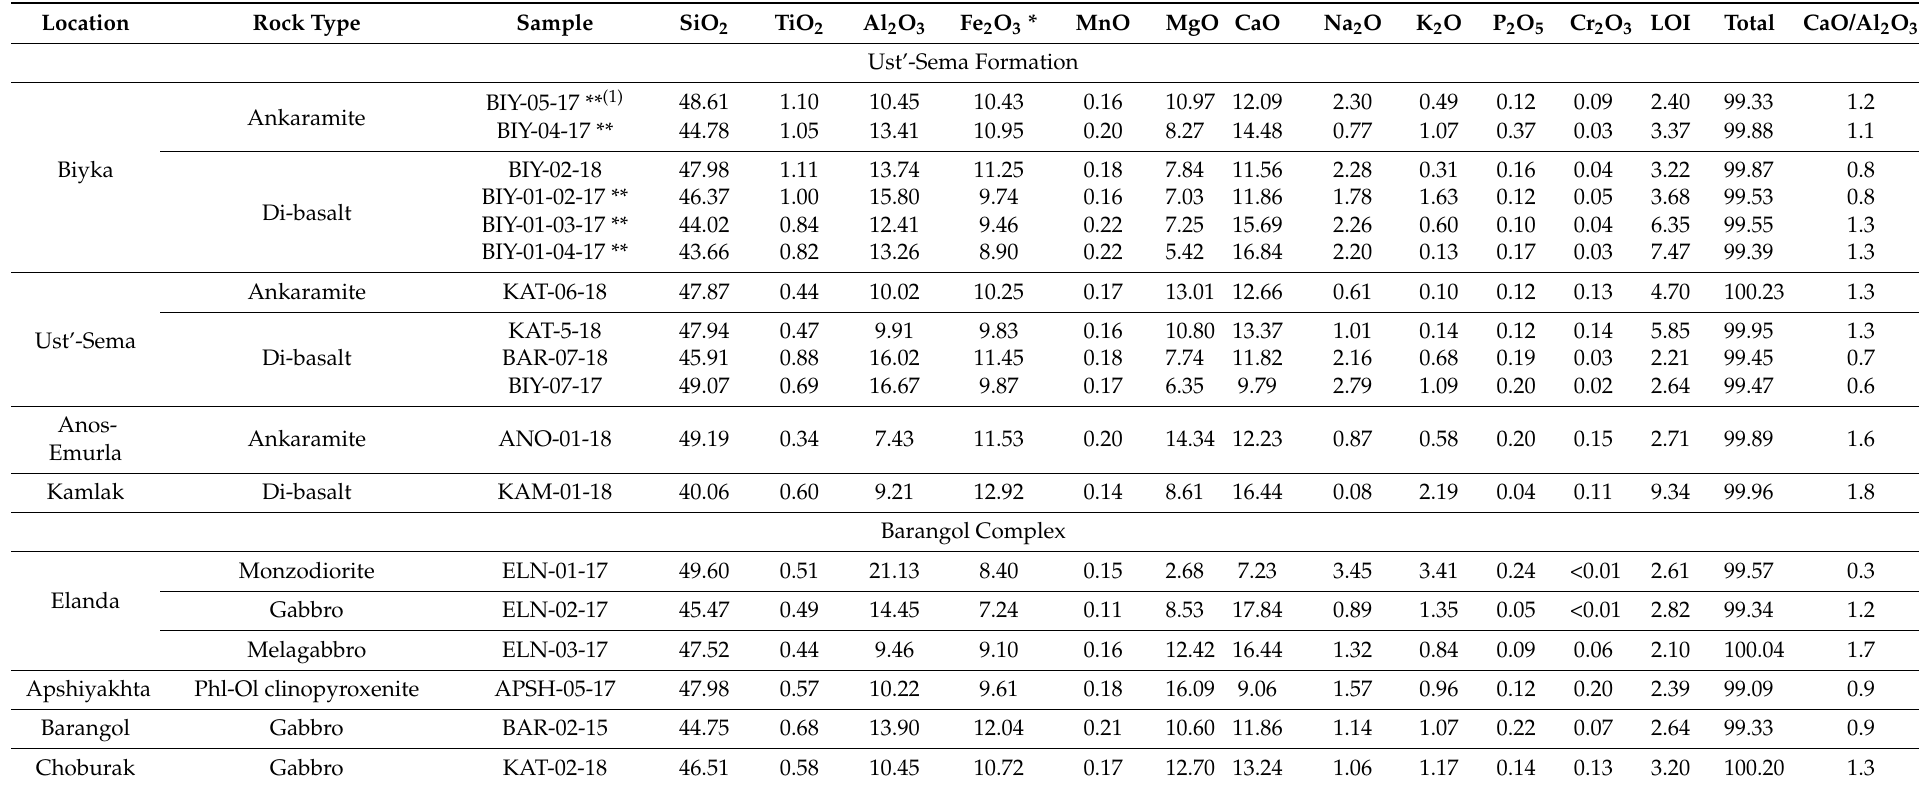
Table 1. Major element composition of the rocks from the Ust’-Sema Formation and the Barangol Complex, Gorny Altai.